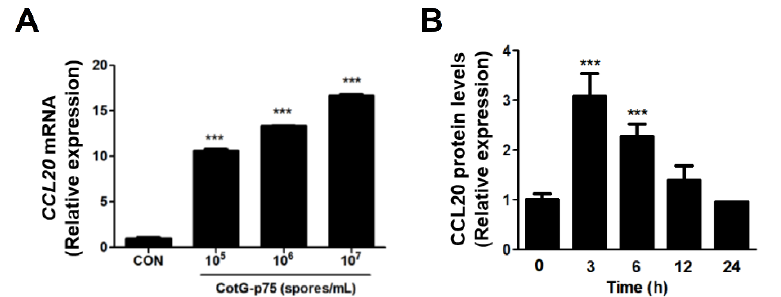
Figure 11. Effects of Cotable 75. on HBEGF mRNA expression ( A ) and HBEGF protein production ( B ) in Caco-2 cells. In panel (A), cells were treated with various concentrations (10 5 , 10 6 , and 10 7 spores/mL) of CotG-p75 for 3 h. In panel ( B ), cells were treated with CotG-p75 (10 7 spores/mL) for various time periods (0, 3, 6, 12, and 24 h). Both mRNA expression levels and protein production levels in treated groups were compared with those of the control group. All data are expressed as mean ± standard deviation ( n = 3). Asterisks (***) indicate a significance difference from the control (***, p < 0.001).